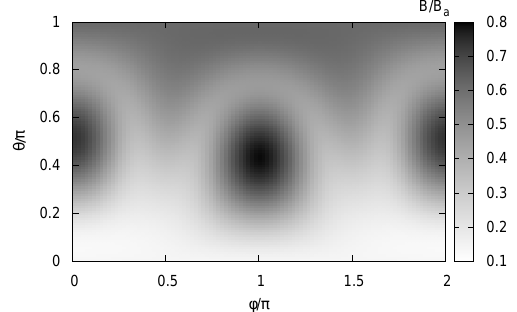
Figure 1: BY Cam photometry. Top: B-band from 7 February 2013. Bottom: R-band from 12 February 2013. Cycle to cycle variations are clearly evident. BY Cam: MHD modeling